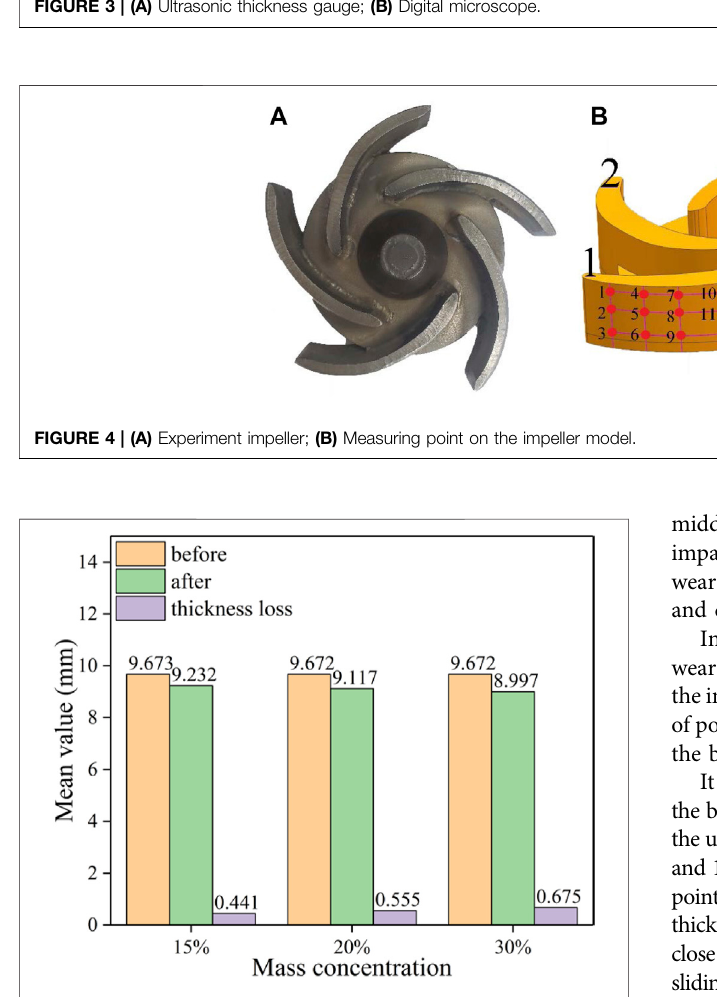
Frontiers in Energy Research |